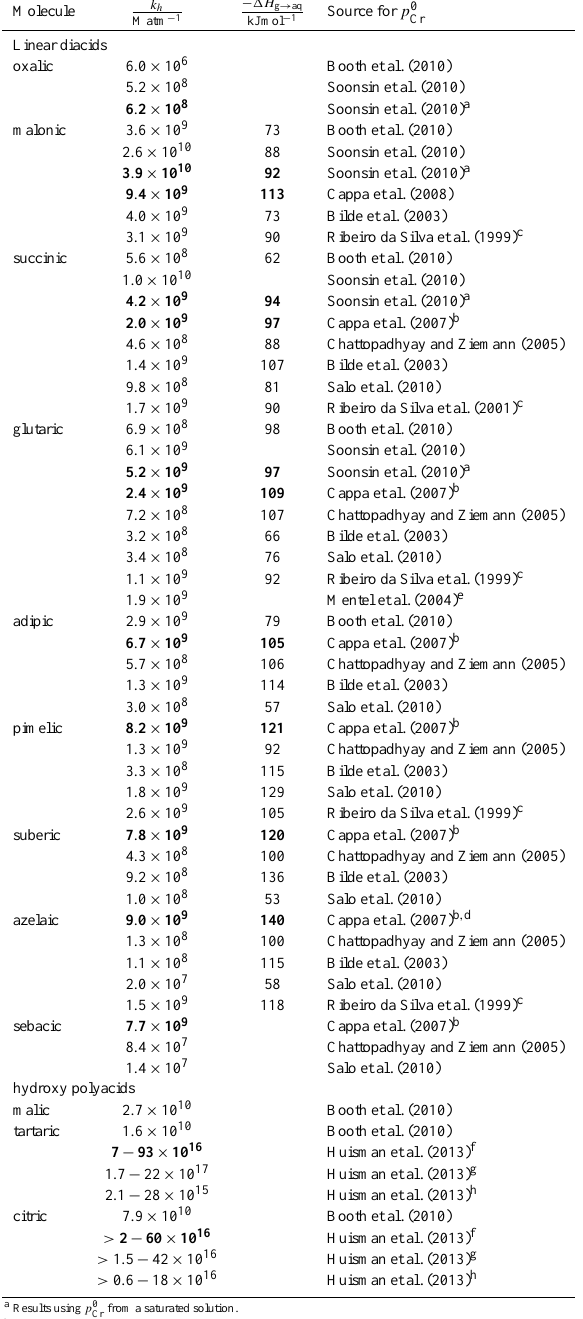
Table 3. HLC data at 25 ◦ C and dissolution enthalpies. The last column provides the source of the solid state vapour pressure, unless otherwise indicated. Recommended values are in bold